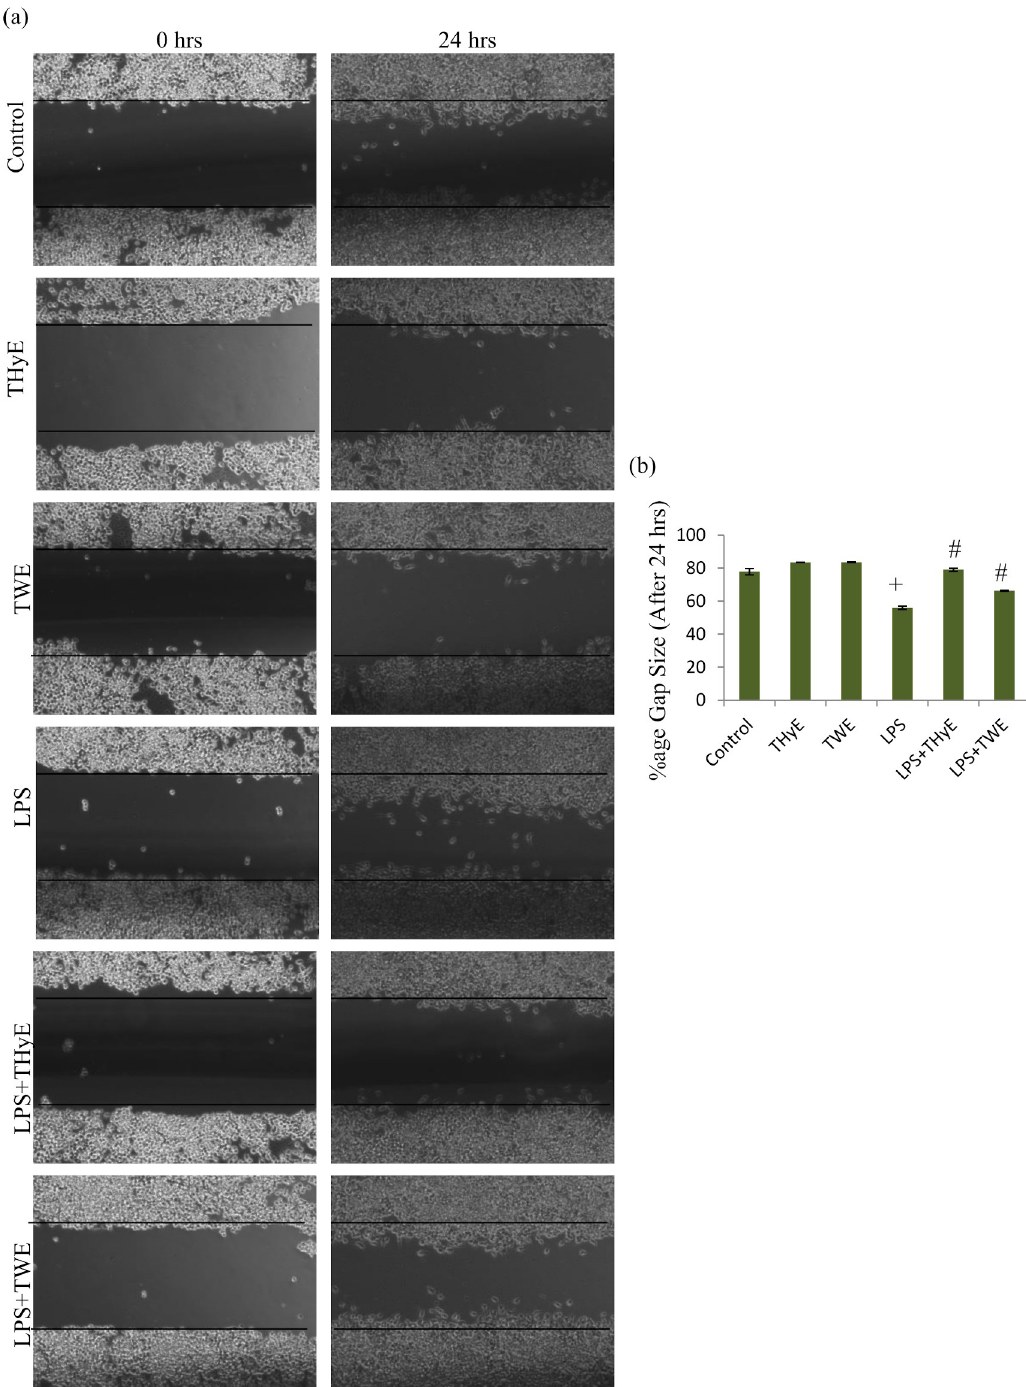
Fig 2. THyE and TWE attenuate the LPS induced migration of the activated BV-2 microglial cells. BV-2 microglial cells were grown as a confluent monolayer, wounded by applying a scratch and treated with THyE (0.2 μ g/mL) and TWE (20 μ g/mL) with and without activation with LPS. (a) Representative Phase contrast images which were taken at 0 h and 24 h after scratching. (b) Histogram depicting percentage gap size after the 24 h (0 h gap was taken as 100%). + p � 0.001 represents statistically significant difference between control and LPS treated group. # p � 0.001 represents statistically significant difference between LPS and LPS +THyE, LPS+TWE treated groups. � p � 0.001 represents statistically significant difference between control and LPS+THyE, LPS +TWE treated